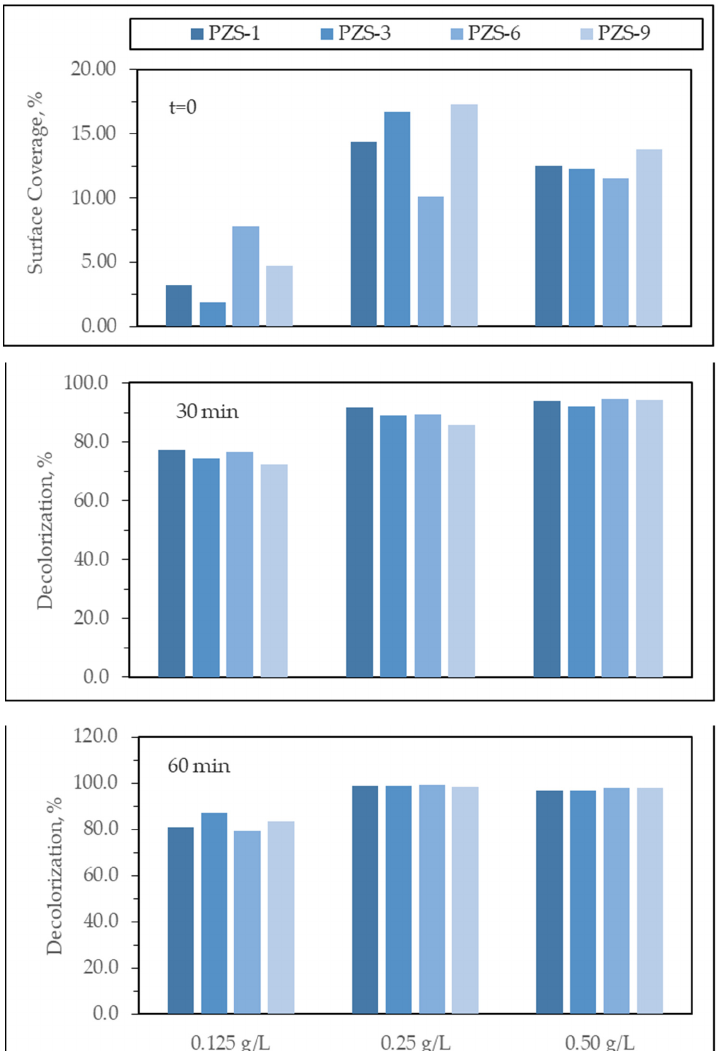
Figure 11. Photocatalytic degradation of MB upon use of PZI specimens: Dose effect.